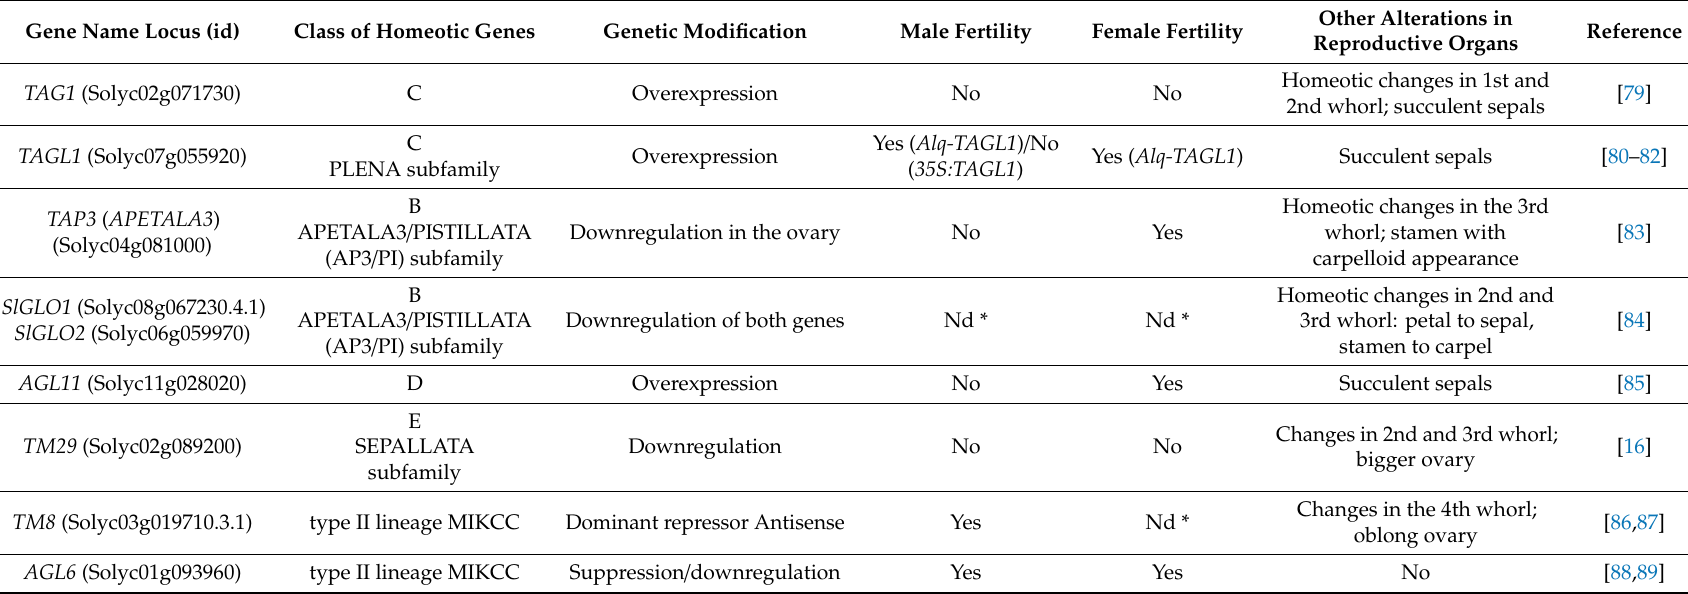
Table 1. MADS-box genes involved in production of fruit in the absence of